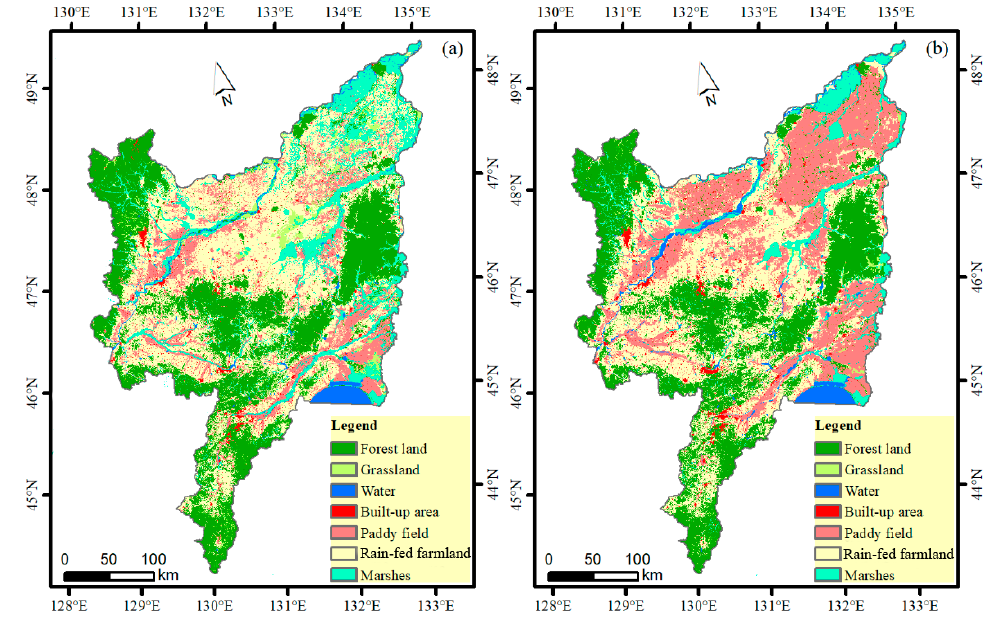
Figure 2. Land use maps of Sanjiang Plain in 2005 ( a ) and 2015 ( b ).